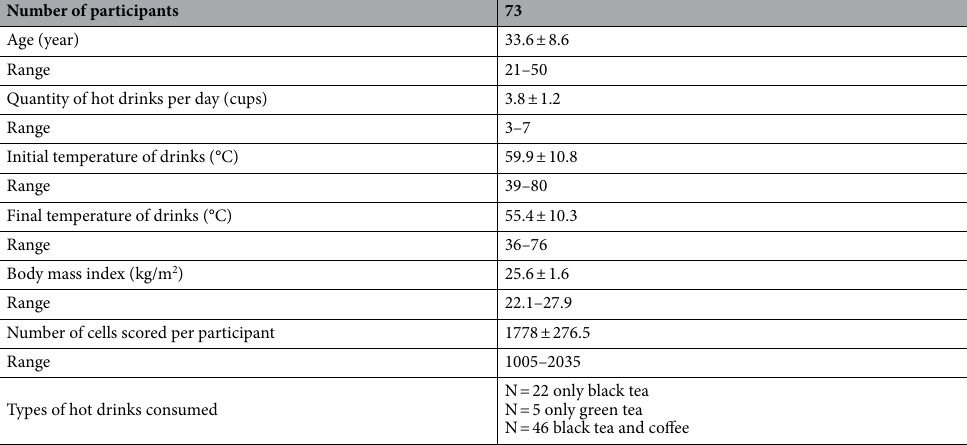
Table 3. Demographic factors and drinking habits of the